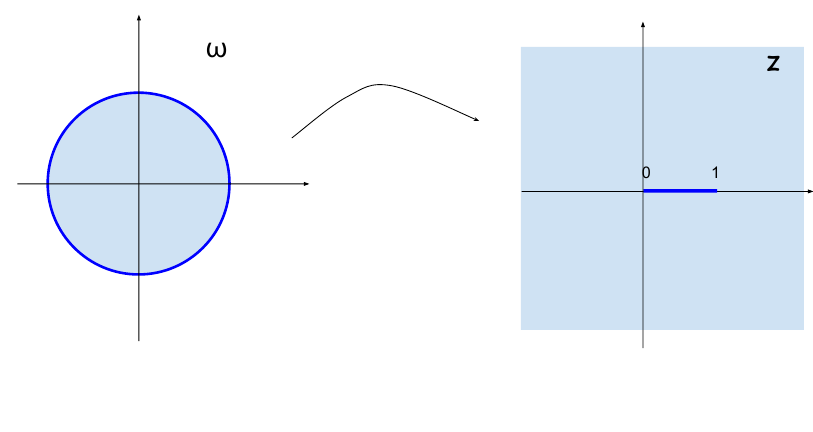
Figure 6. Conformal transformation of the unit disk to the complex plane with a slit